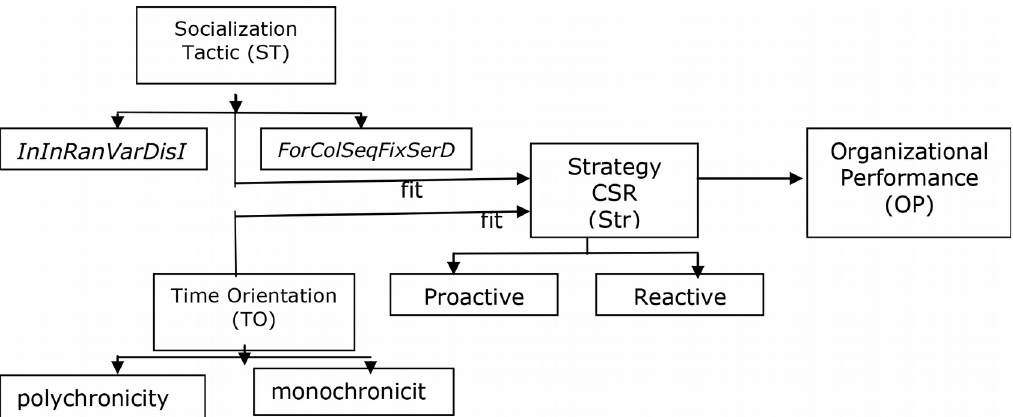
Figure 1. The Research